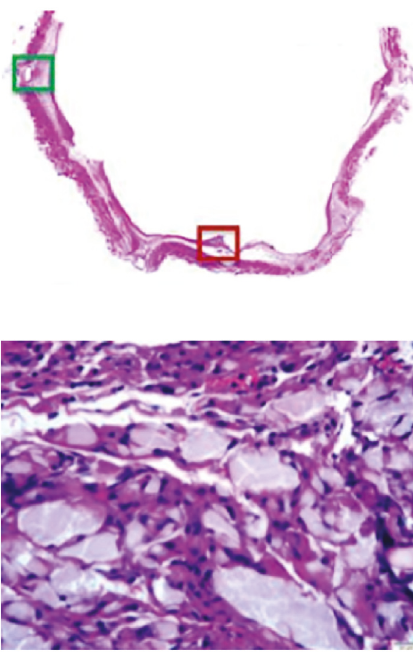
Figure 5: Histological images of the integration of the Sentry filter arms into the wall of the inferior vena cava. Above: section cut through the tips of the filter arms stained with hematoxylin and eosin. Below (dark red box in image above): residual filament material surrounding chronic inflammatory cells adjacent to the fully incorporated tip of a filter arm. Reprinted with permission from Gaines et al.